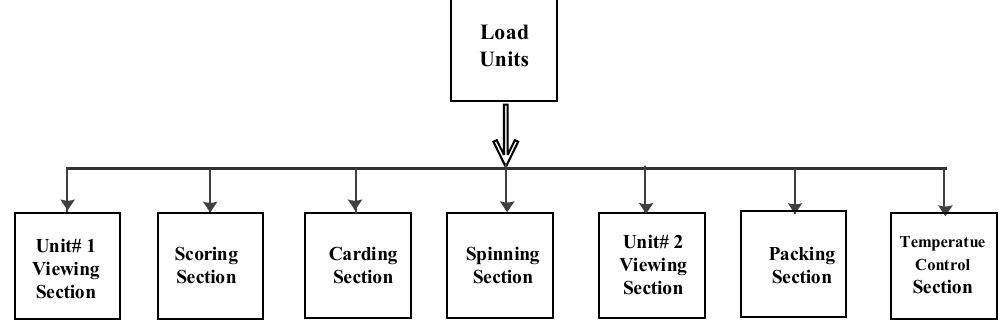
Figure 2. Industry load units. Table 1. Specification of industry